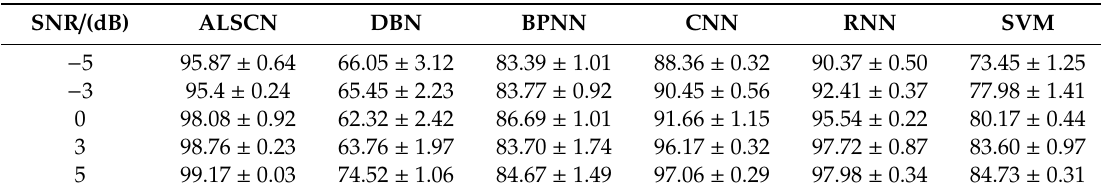
Table 10. The accuracy of di ff erent models with di ff erent SNR value on MFPT. SNR /